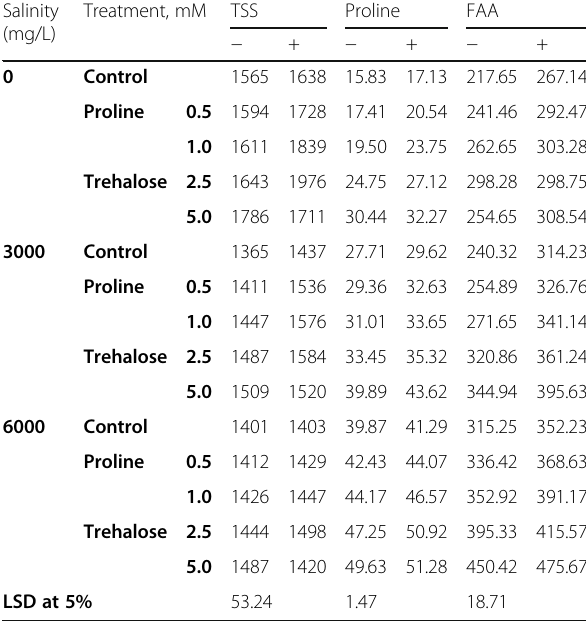
Table 5 Total soluble sugars, proline, and free amino acids